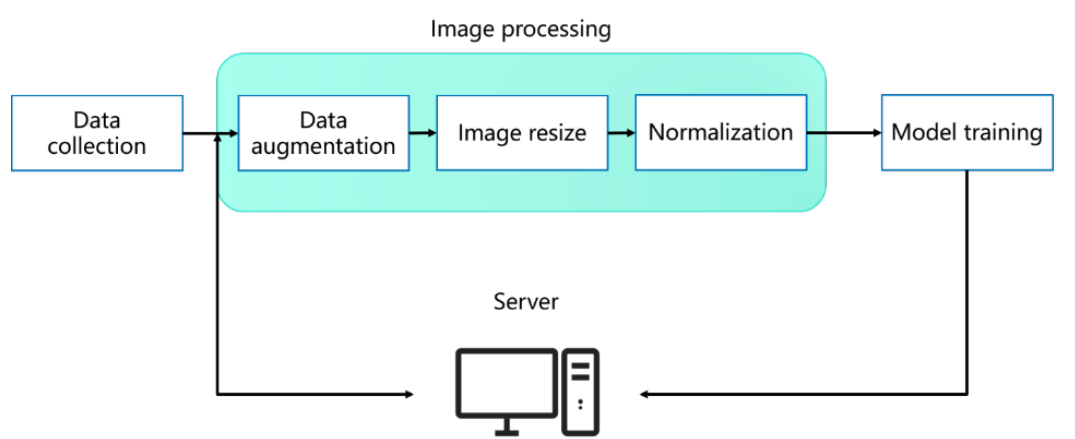
Figure 9. Framework of the system.